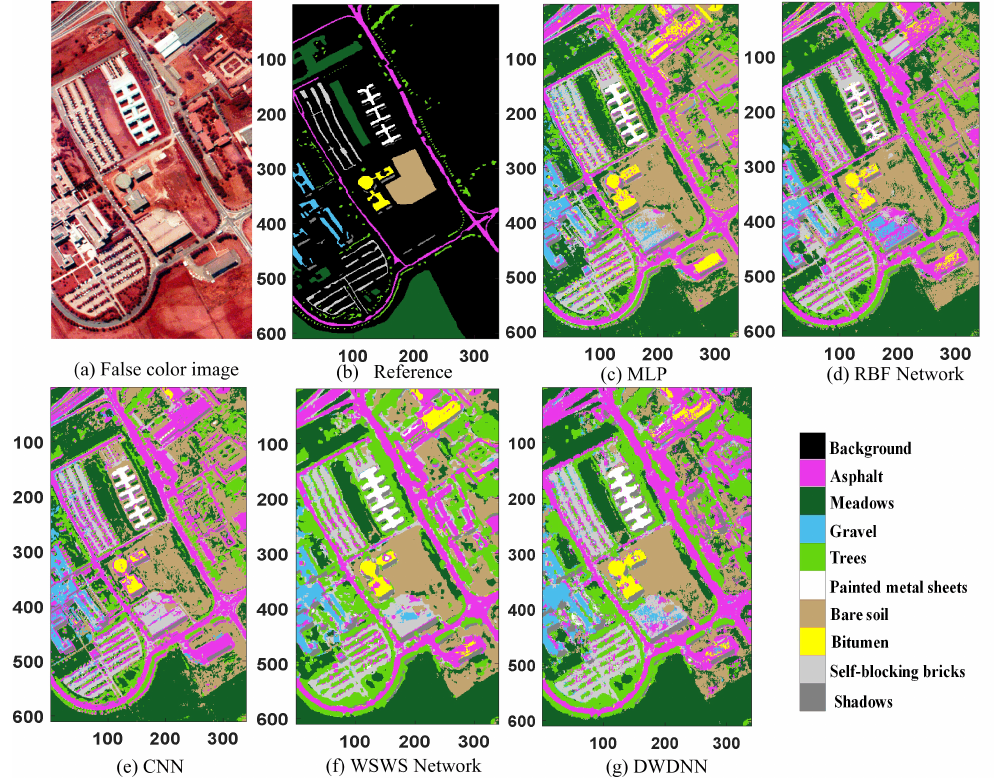
Figure 6. Classification results of the Pavia University dataset (the instances without class information were also predicted). ( a ) False color image, ( b ) reference image, ( c ) MLP, ( d ) RBF Network, ( e ) CNN, ( f ) WSWS Network, and ( g )